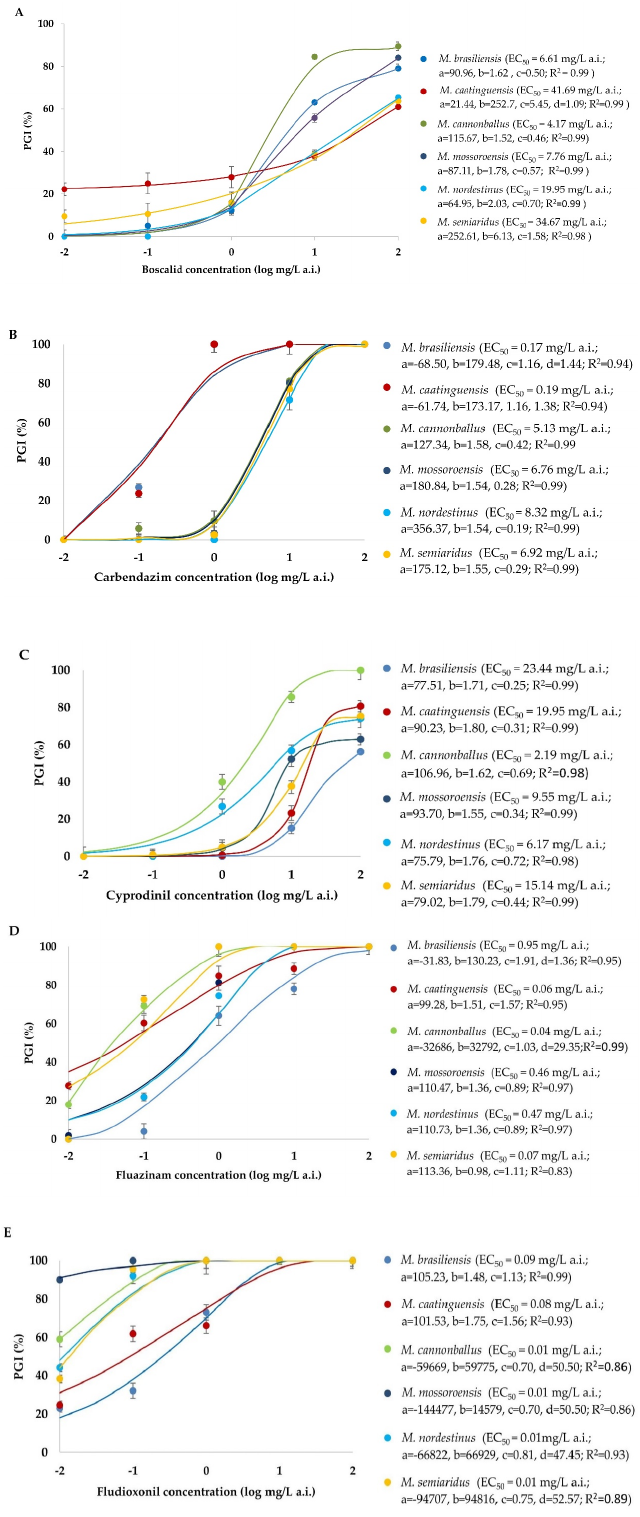
Figure 3. Regression equation, coe ffi cient of determination (R 2 ) and half-maximal e ff ect concentration (EC 50 ) of each Monosporascus spp. For the fungicides ( A ) boscalid, ( B ) carbendazim, ( C ) cyprodinil, ( D ) fluazinam, and ( E ) fludioxonil. y = adjusted with the values of percentage of growth inhibition (PGI) at concentrations of 0.01, 0.1, 1, 10 and 100 mg / L a.i. per fungicide. EC 50 = 50% mycelial growth inhibition concentration calculated from the regression equation (mg /